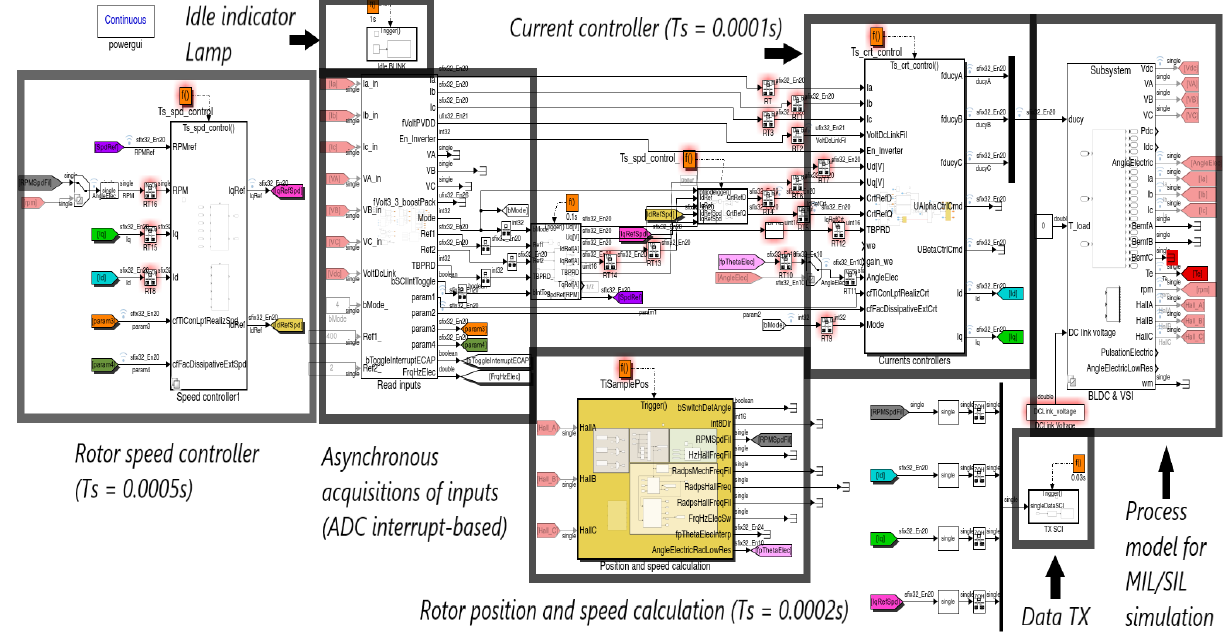
Figure 6. View of the Simulink model. Table 1. Control